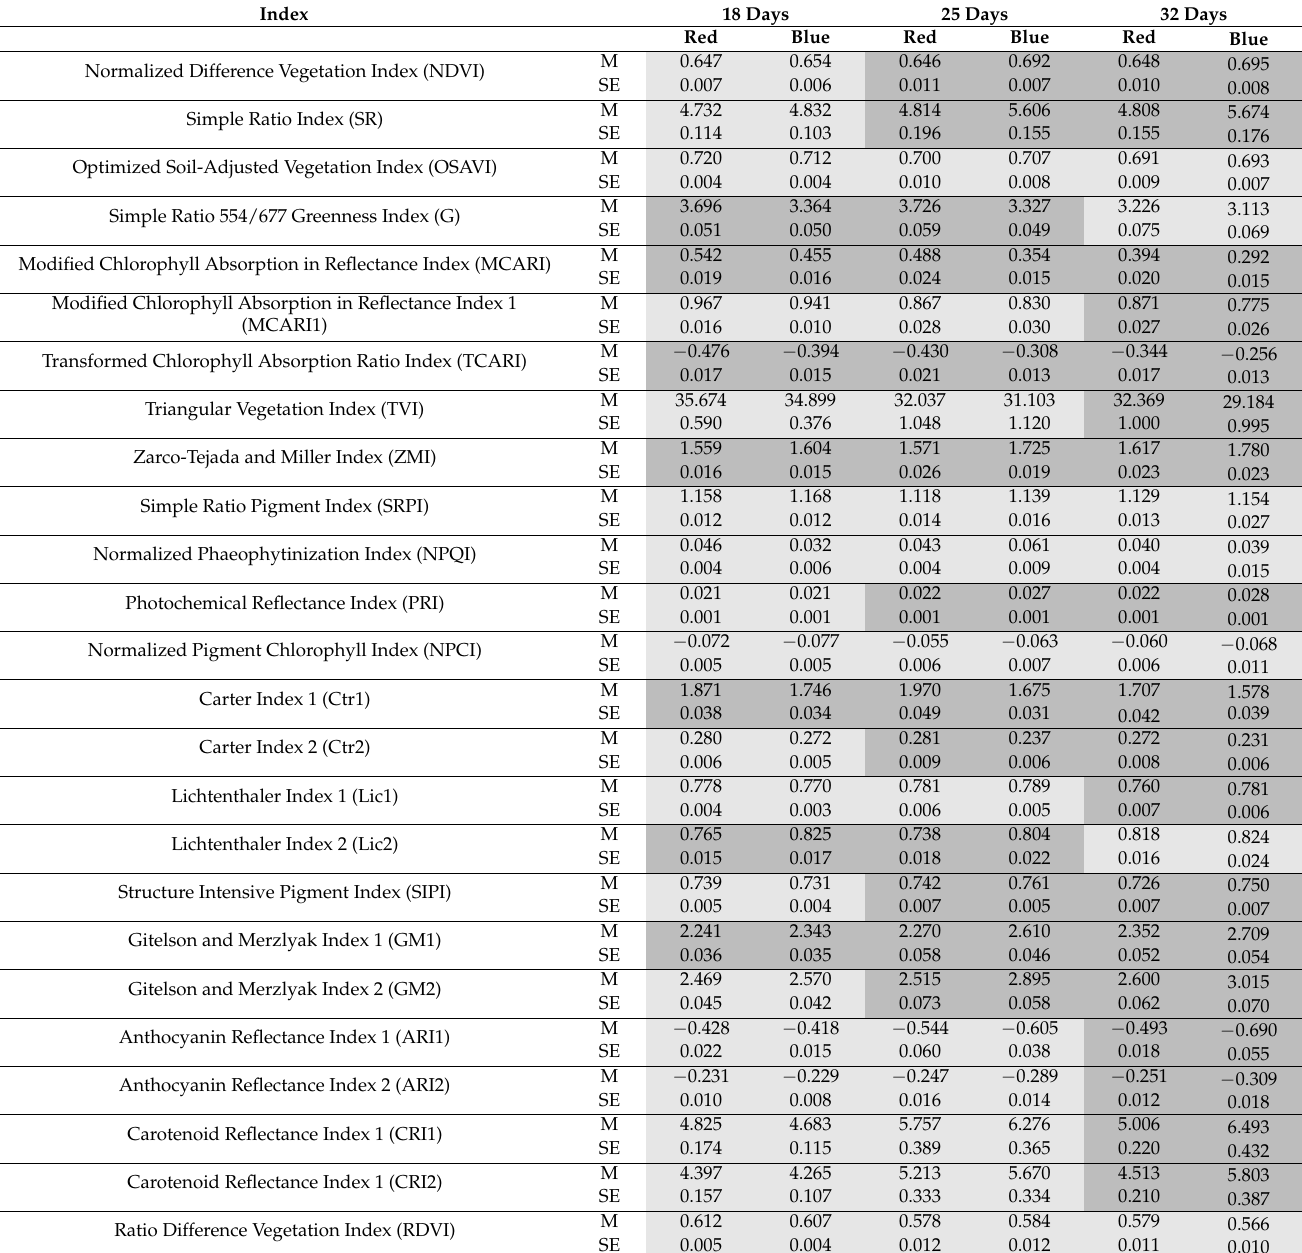
Table 1. Influence of the red and blue illumination variants during lettuce cultivation on the re- flectance indices in leaves after 18, 25, and 32 days of